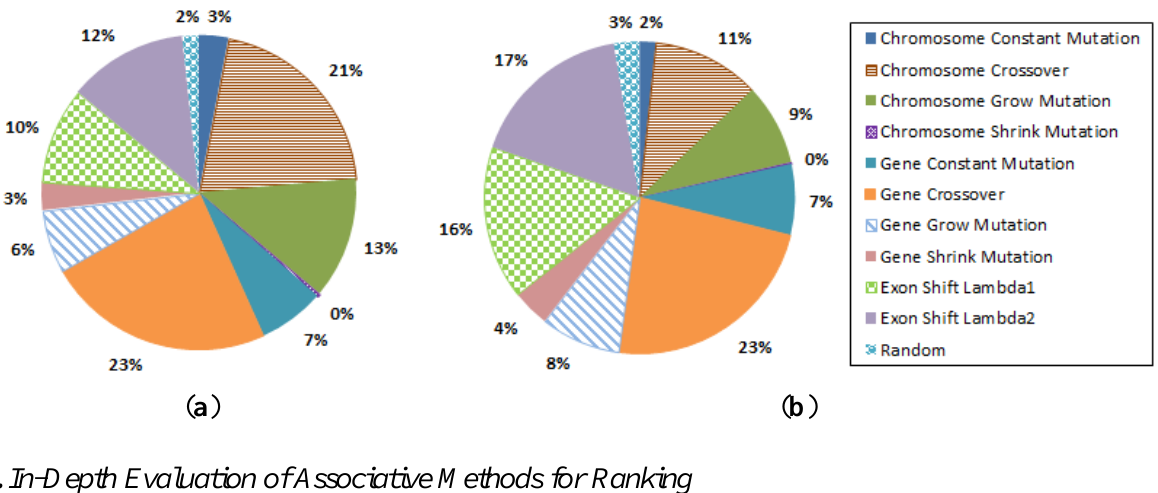
Figure 5. Relevant genetic operations as percentage when ranking images by semantics on the ( a ) UCI Statlog Landsat data set and ( b ) WROC data